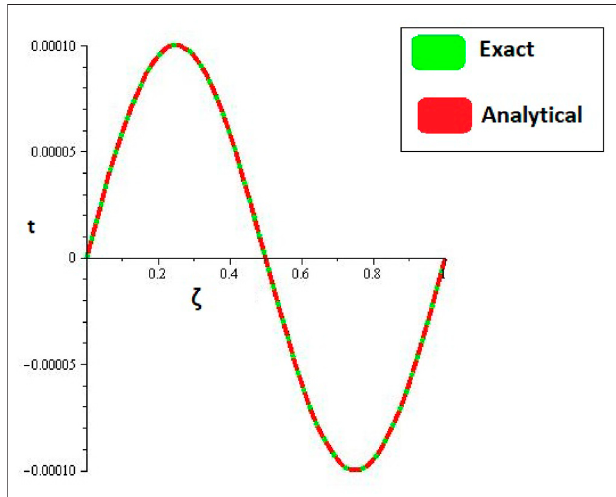
FIGURE15| Comparison forthe exactand analyticalsolution at γ =1 for Example 4.